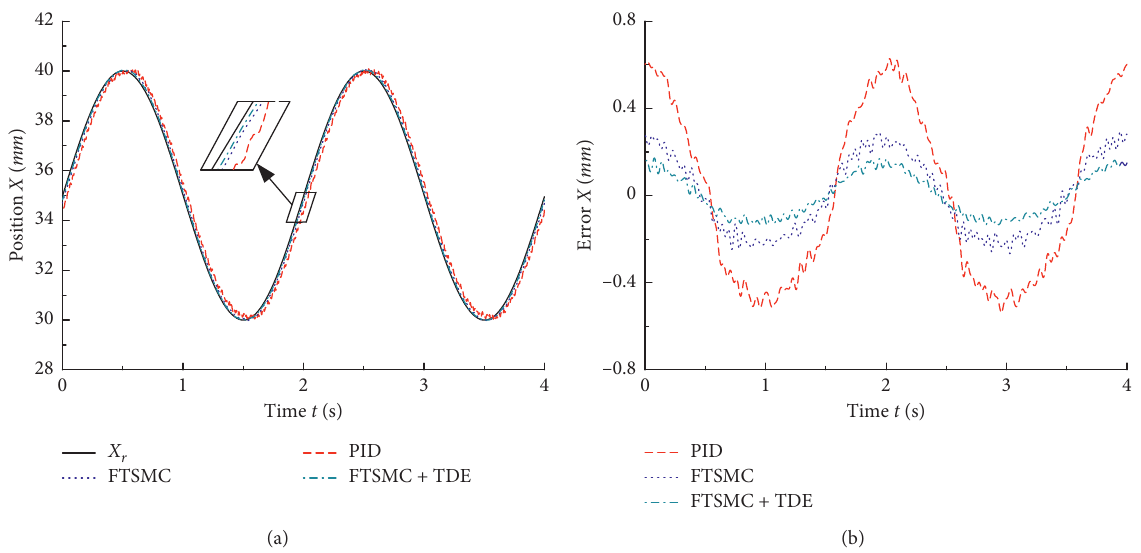
Figure 14: Position error under working condition ① in Table 5. (a) Position of 5 mm amplitude and 0.5Hz frequency. (b) Position error of 5mm amplitude and 0.5Hz frequency.